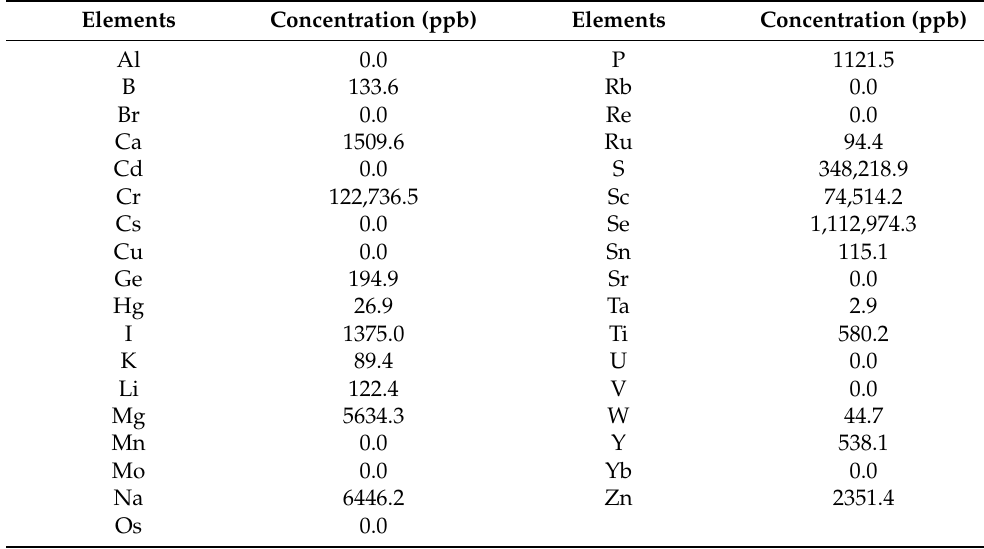
Table 1. ICP mass spectrum of surfactin isomers from surfactin produced by Bacillus pumilus HY1.